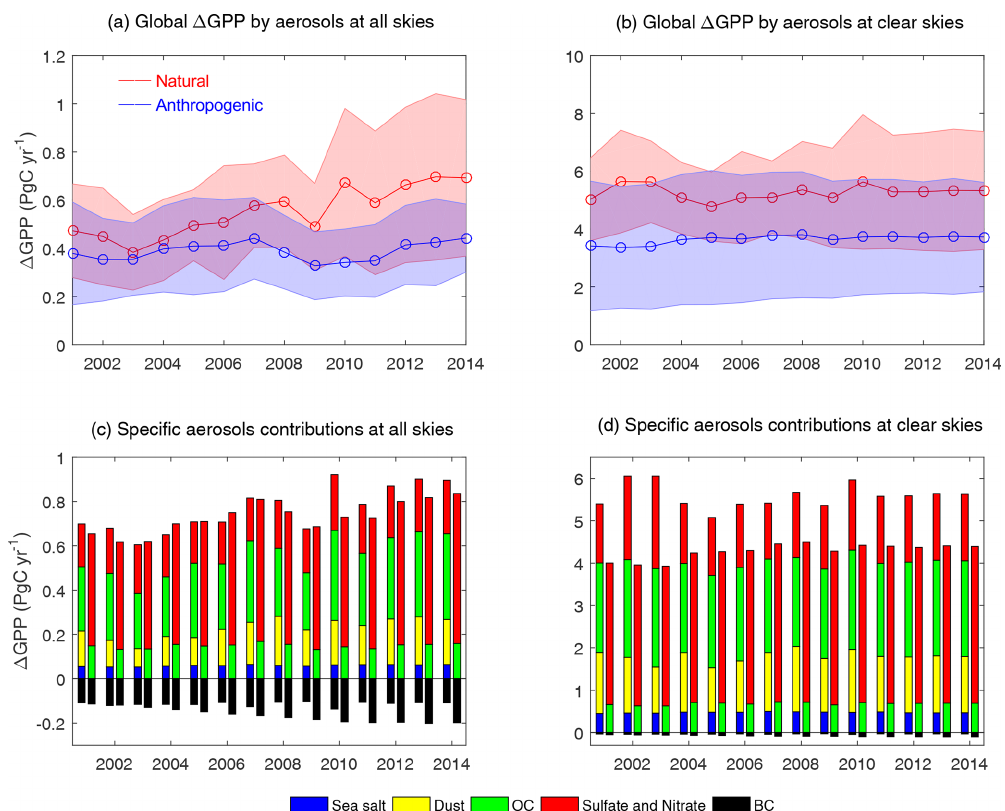
Figure 7. Interannual variations in GPP changes induced by the DFE of natural and anthropogenic aerosols under (a, c) all skies and (b, d) clear skies from 2001–2014. The left and right bars at each year in (c) and (d) represent the effects of natural and anthropogenic aerosol species, respectively. The hollow circles and shadings in (a) and (b) represent annual mean and standard deviation of aerosol-induced GPP changes from all months in each year. The black, green, red, yellow, and blue bars indicate the effects of BC, OC, sulfate and nitrate, dust, and sea salt aerosols,